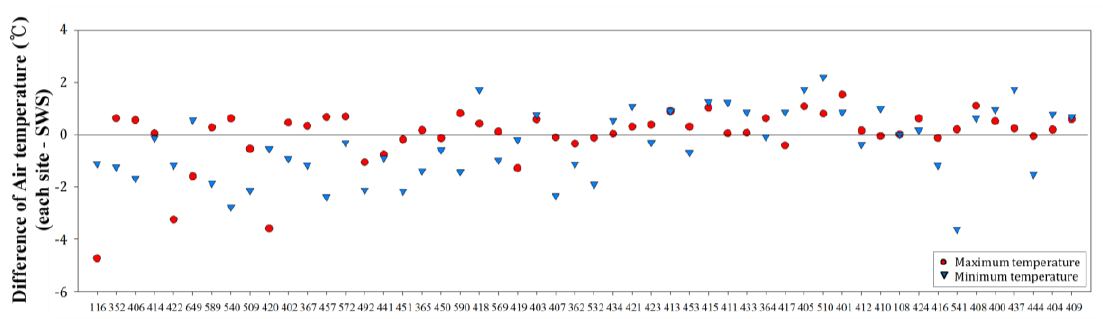
Figure 5. Mean difference of daily maximum air temperature (red circles) and daily minimum air temperature (blue triangles) for air temperatures observed in Seoul weather station (SWS) during July to August 2015.